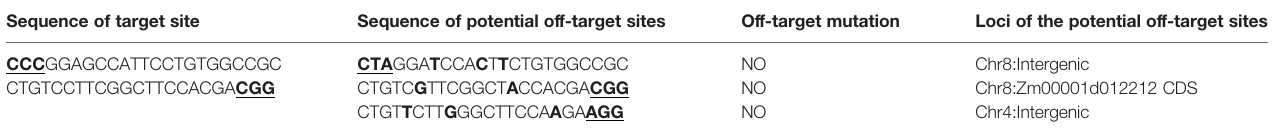
TABLE 1 | Evaluation of the off-target effects of